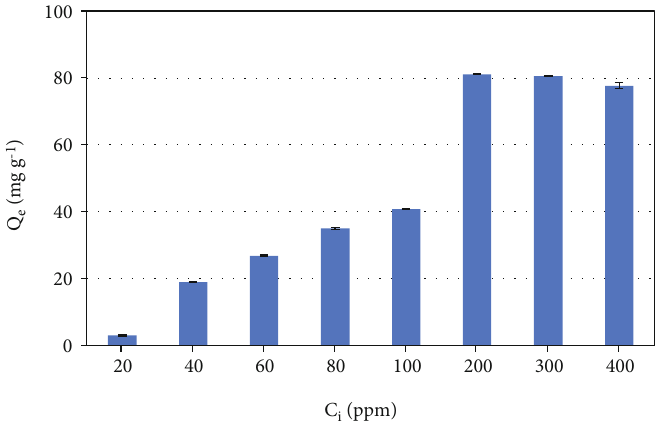
Figure 4: The e ff ect of initial dye concentration on removing MB from solution using BC500 (room temperature, unadjusted pH, and contacttime = 3 h